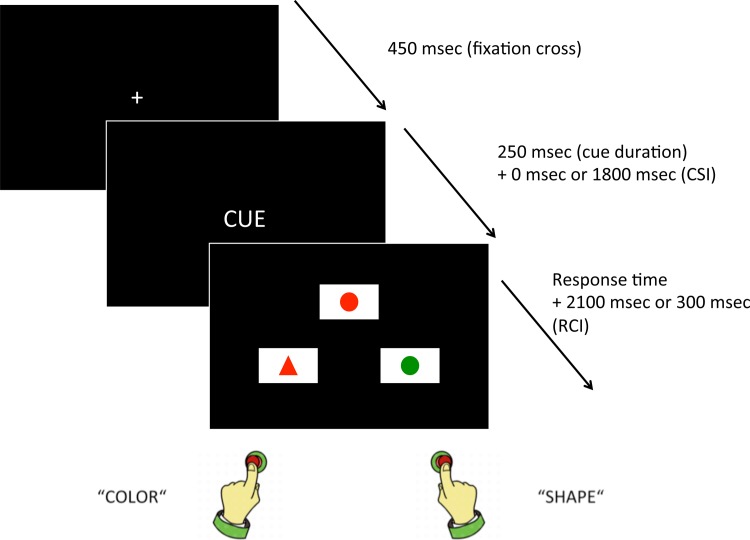
Switching task.For each trial, a fixation cross is followed by a cue, after which three figures are presented. Participants are asked to decide which of the 2 lower figures matches the top one, depending on the cue, and is required to press the corresponding key (left key for left figure and right key for right figure).